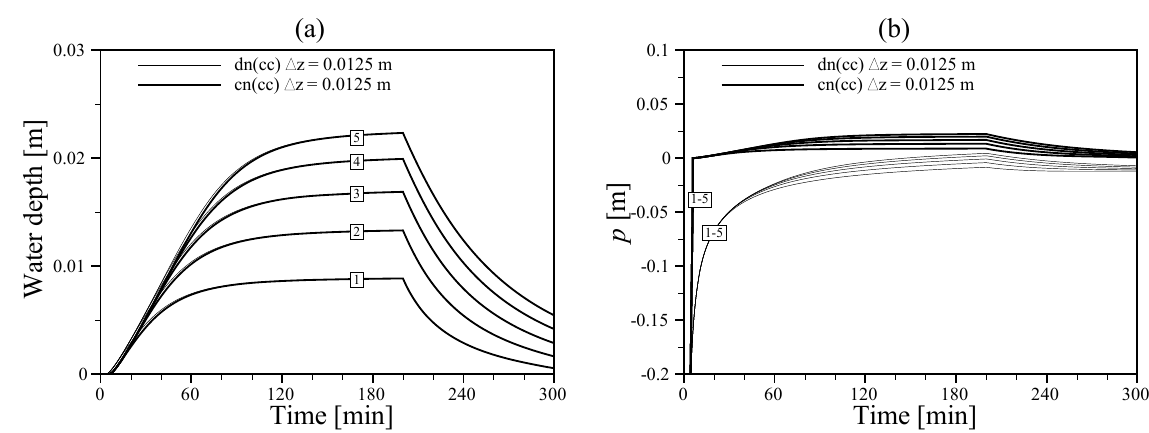
Time [min] Figure 8. Simulated values at the common nodes for excess infiltration on a hillslope (second scenario) with a cell-centered scheme and (cid:49)z = 0.0125m. (a) Water depths. (b) Pressure heads. Nodes are numbered 1–5 in the downslope